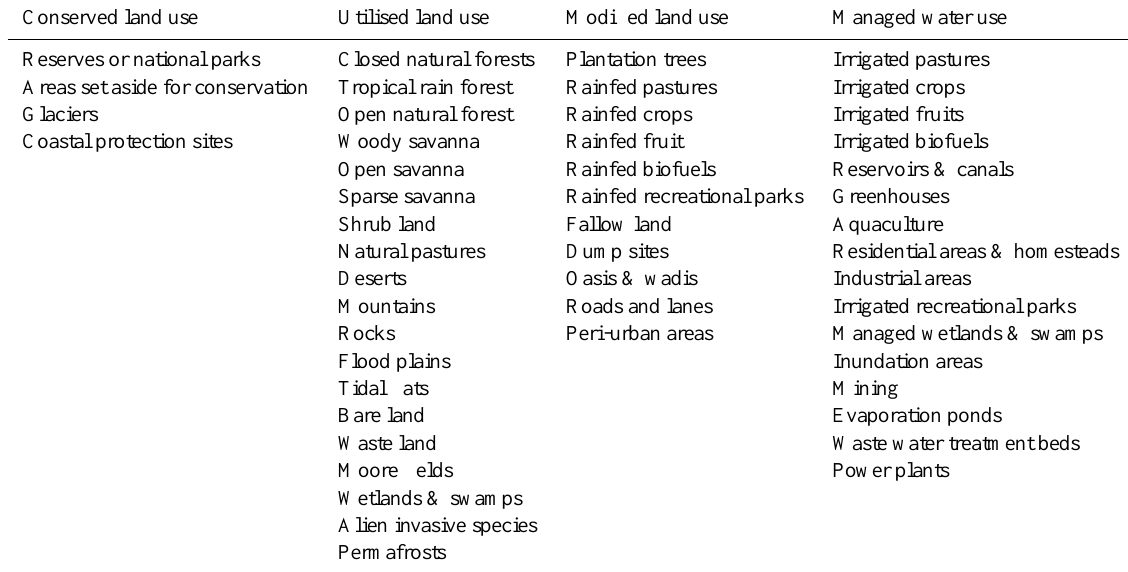
Table 2. Categories of land use classes with similarity in ecosystem services, provisioning services, human interaction and interventions in the hydrological cycle. These classes form the basis for management options in WA +